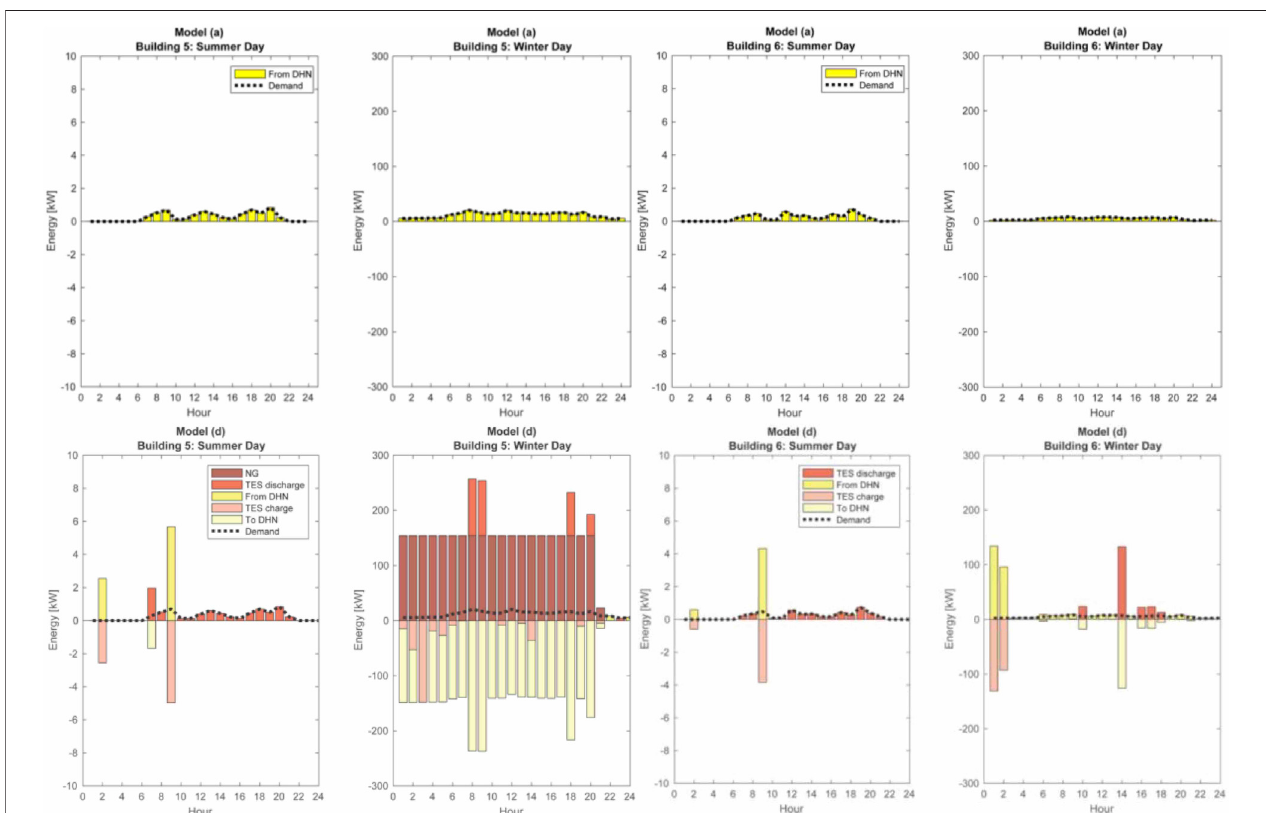
FIGURE15| Timesseriesoftheoutputoftechnologiesforatypicalwinterdayandatypicalsummerdayforbuilding5and6fromthemodel (A)(top) andmodel (D) (bottom)